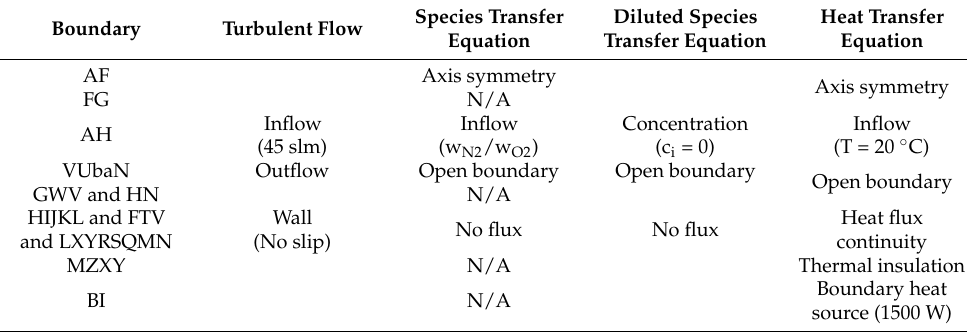
Table 2. Boundary condition settings of the computing